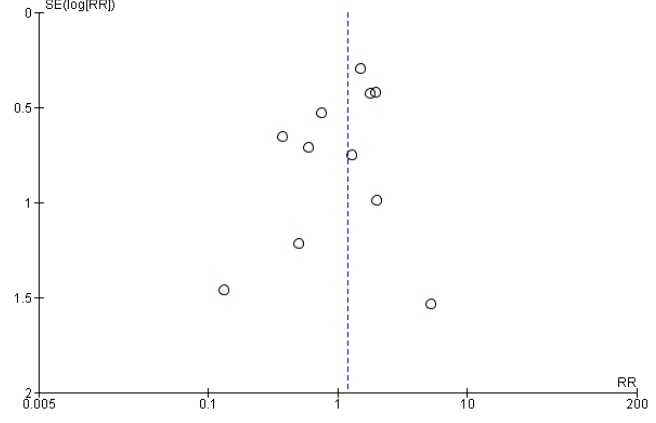
Figure 3. Funnel plot of studies evaluating the administration of probiotic and preterm birth.